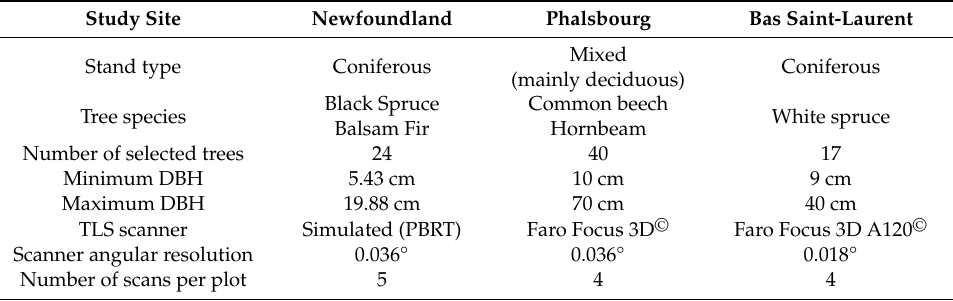
Table 1. Overview of the data set characteristics and scanning protocol for the three test sites.